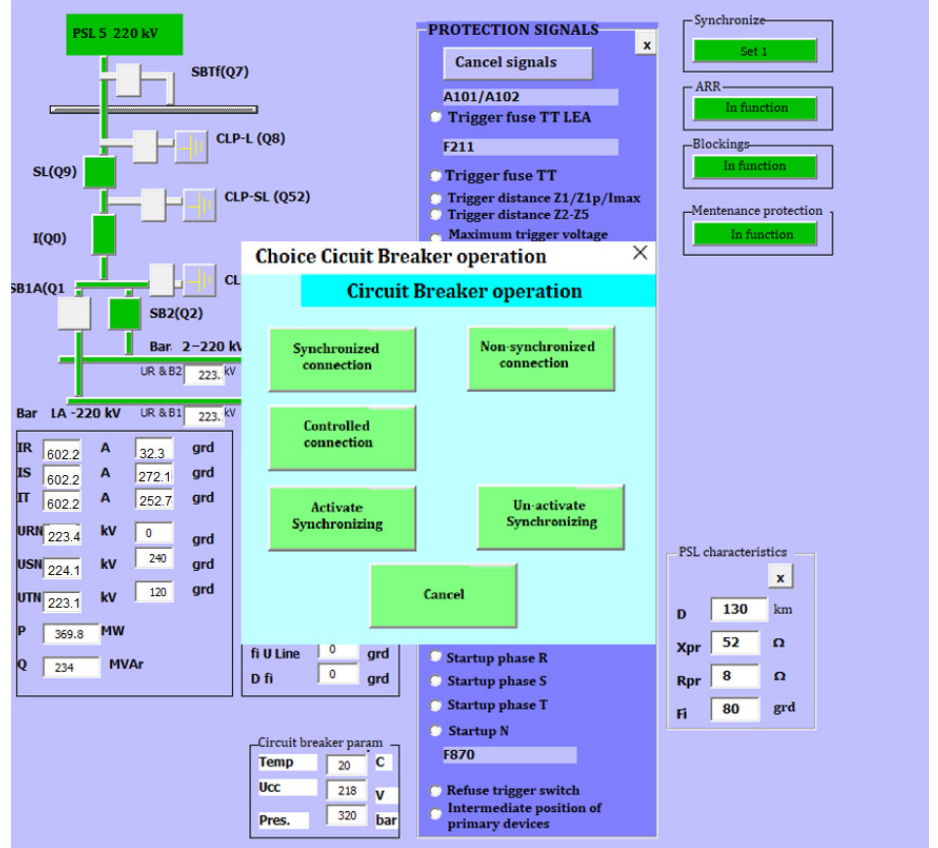
Figure 27. The control screen of the circuit breaker’s connection.